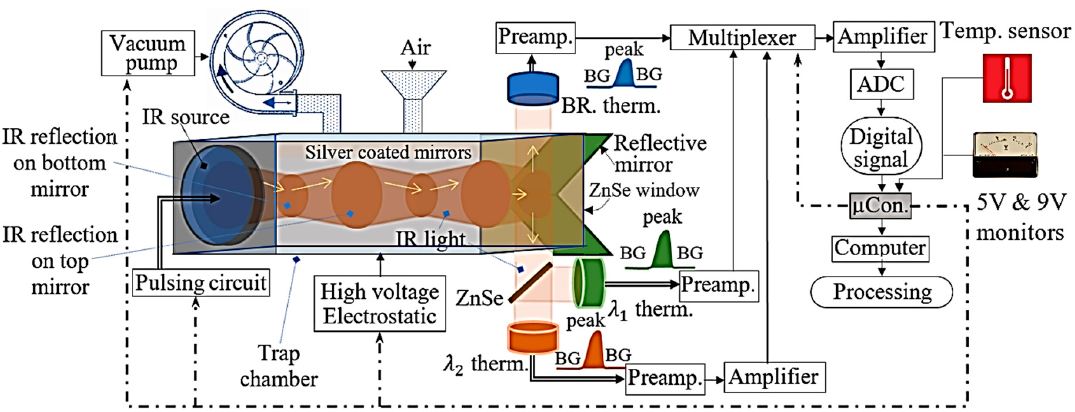
Figure 2. High voltage trap chamber and the thermopiles, circuit of the amplifiers and operation diagram.